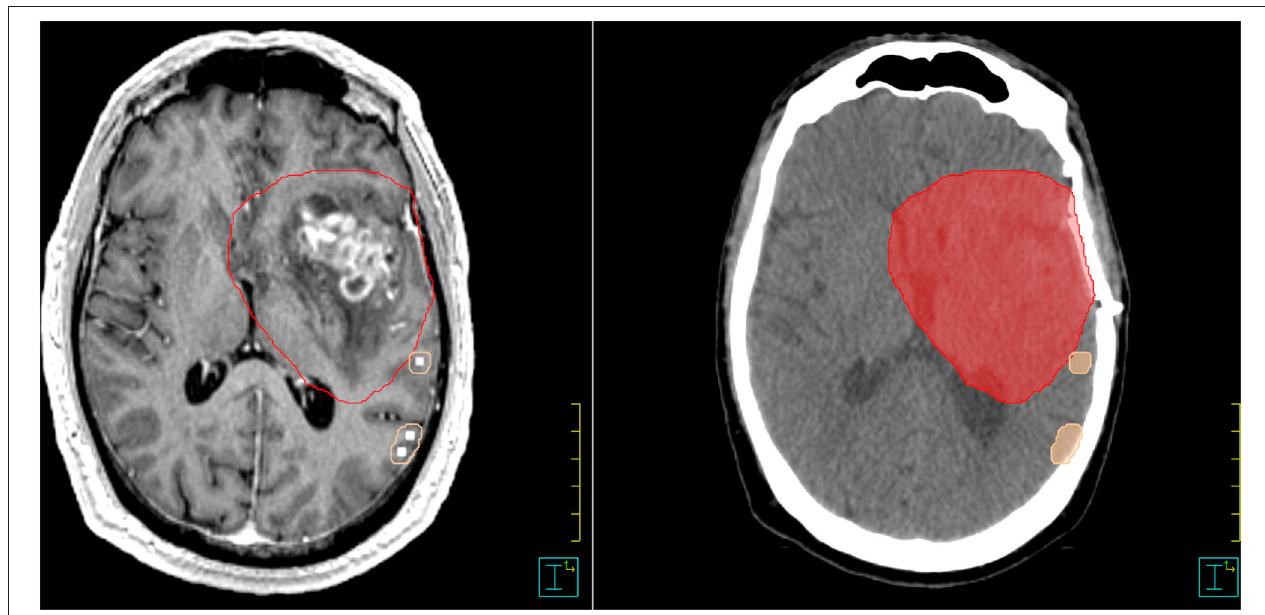
FIGURE 1 | Example for nTMS-mapping and contouring in Pinnacle. nTMS, navigated transcranial magnetic stimulation. PTV = red color; motor cortex = skin